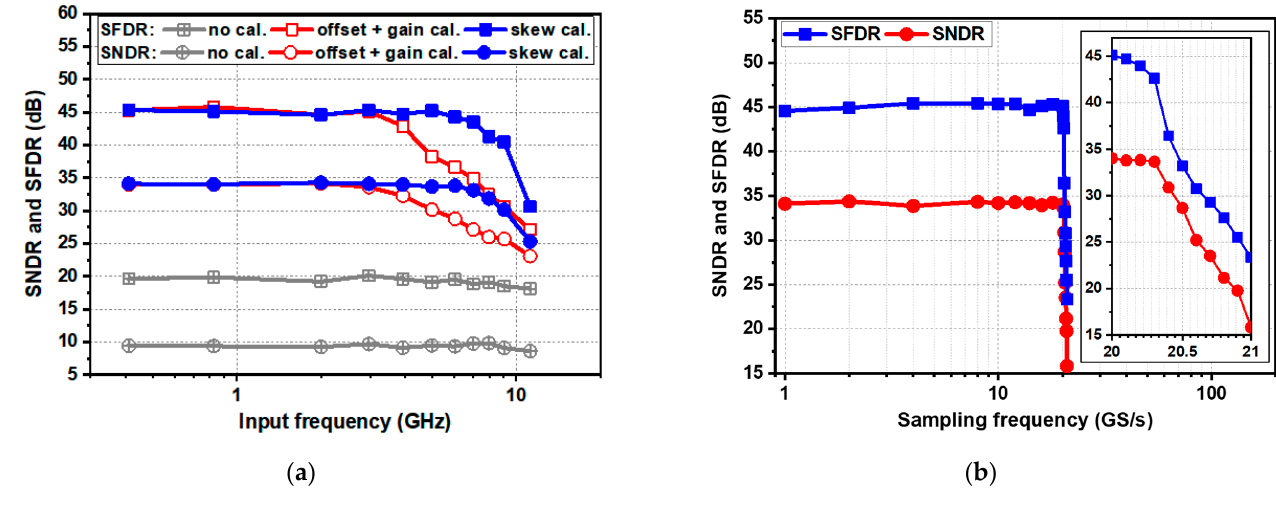
Figure 18. Measured SNDR and SFDR versus various ( a ) input frequencies at 20 GS/s and ( b ) conversion rates with a 0.828 GHz input frequency.